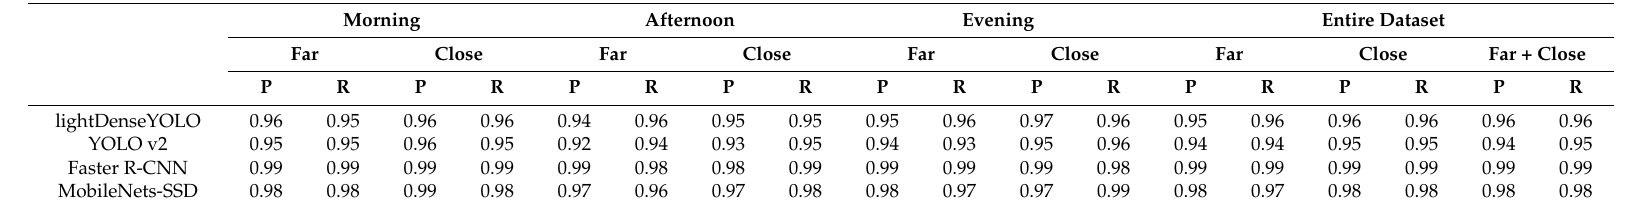
Table 7. Precision (P) and recall (R) at IoU = 0.5 of different CNN marker detectors.